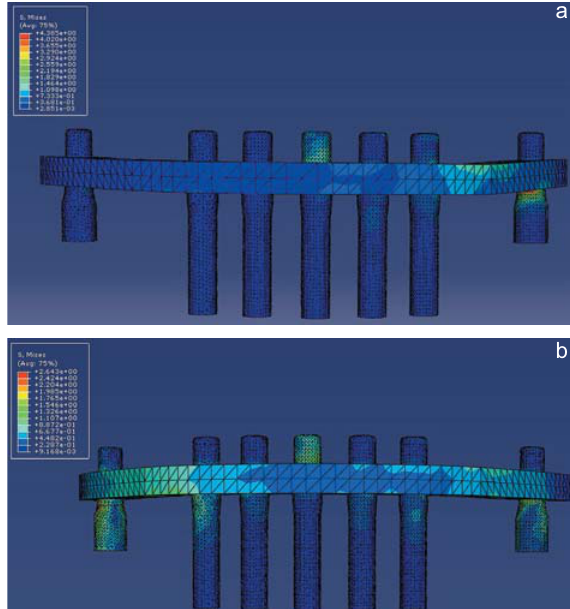
Figure 3- Distribution of the equivalent stress generated by disocclusion in canine guide occlusion (CGO) (a) and bilateral balanced occlusion (BBO) (b) on the implants and metallic infrastructure. Frontal view